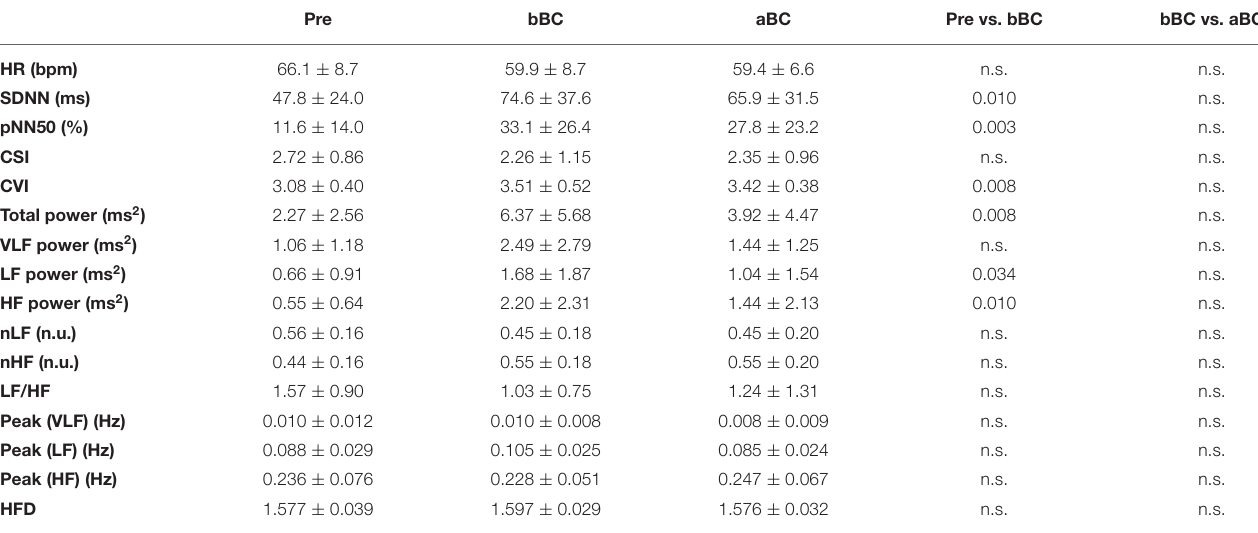
TABLE 2 | Data extracted from the ECG signal for the whole study population. Pre bBC Pre vs.